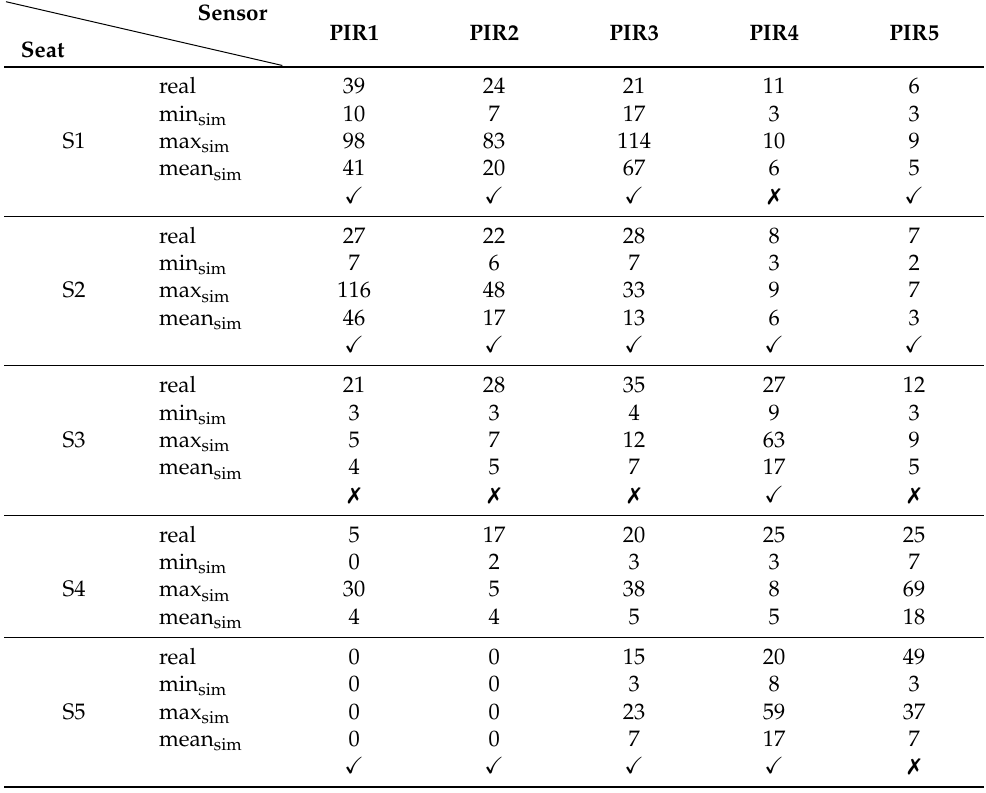
Figure 8. Relative frequency histograms of summed motion data for seat S1. Subplot ( a ) contains data from PIR sensor 1; ( b ) PIR sensor 2; ( c ) PIR sensor 3; ( d ) PIR sensor 4; ( e ) PIR sensor 5. Histogram data (gray bars) is from the simulated versions of the experiment. The red line in each subplot marks the result from the real-world version of the experiment for the same seat and sensor combination. Table 1. Summary of motion sensor data collected during the experiments of study A for every combination of seat and motion sensor. ‘real’ indicates the sum of motion sensor data collected during the real-world version of the experiment. min sim , max sim and mean sim denotes the minimum, maximum and mean amount of motion sensor data collected across all repetitions of the simulated experiment. The ‘ (cid:88) ’ symbol indicates that the motion sensor data collected in the real-world experiment is within the lower/upper range of the simulated motion sensor data. Conversely, the ‘ (cid:55) ’ symbol indicates that the real motion sensor data is outside the bounds of the simulated